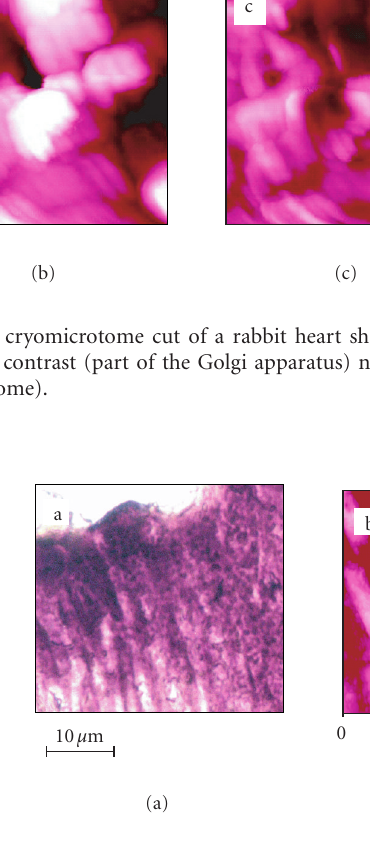
Figure 20: Microphoto (a) and shear-force AFM (b) of a stained (toluidine blue and osmium tetroxide) shrimp eye in the peripheral region; the Z range in the AFM is 4 μ